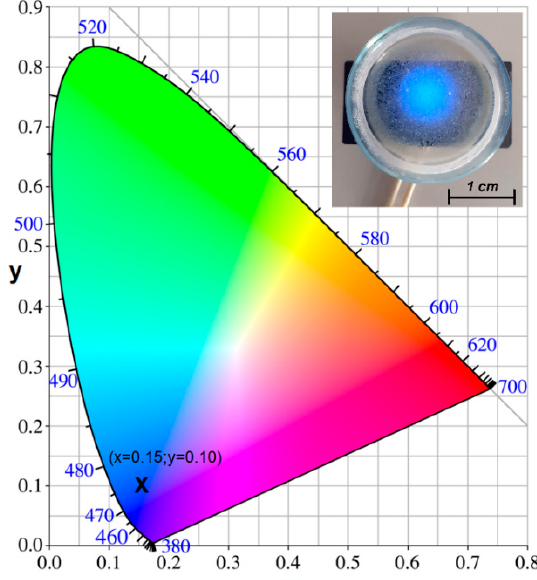
Figure 5. The chromaticity diagram of the Eu 2+ -doped SiO 2 -CaF 2 glass-ceramic annealed in a reducing atmosphere showing chromaticity coordinates according to the Commission Internationale de l’Eclairage (CIE). The inset shows the image of the glass-ceramic powder annealed in a reducing atmosphere uniformly spread on the bottom of a Petri dish observed under a 345 nm UV light spot.